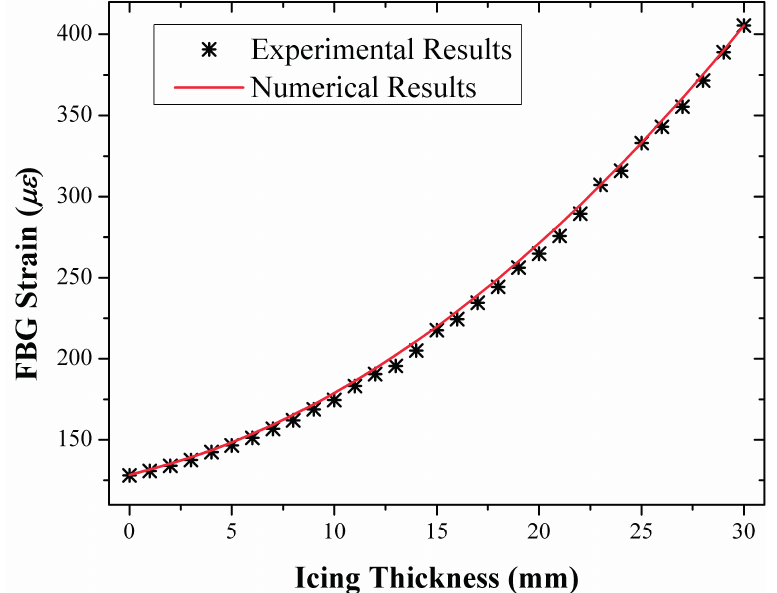
Figure 9. Comparison of experimental and simulation results of FBG strain as a function of icing